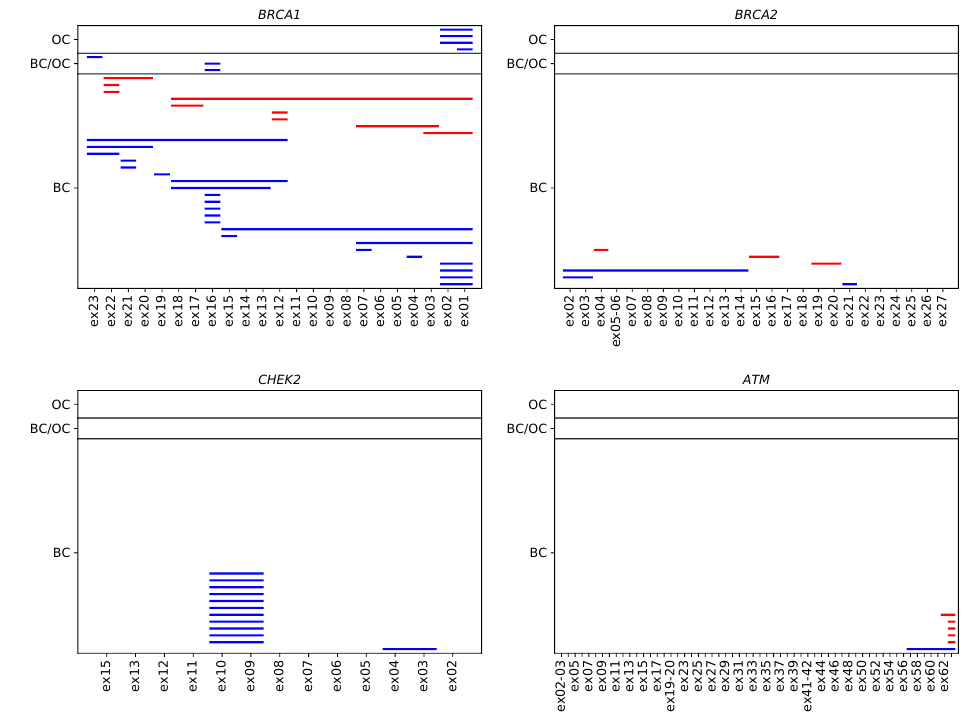
Figure 2. Verified CNVs in the four most frequently affected BC/OC predisposition genes in 4208 individuals according to phenotype. Each line represents a CNV spanning the corresponding sequencing targets in BRCA1 , BRCA2 , CHEK2 , and ATM . Deletions are shown in blue, and duplications are shown in red.